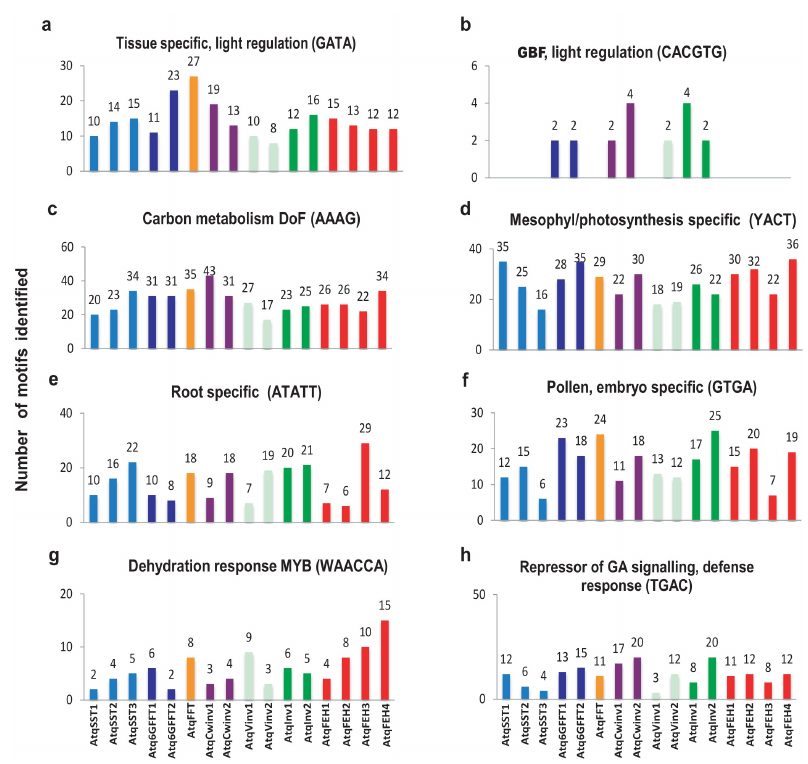
Figure 3. Abundance of transcription factor regulatory motifs identified in PGHF32 promoter regions. Conserved motifs and their associated regulatory process are indicated above each graph. PGHF32 members are indicated at the foot of each column on the x-axis and the y-axis shows the numbers of motifs identified. Each color indicates the different PGHF32 members for present in the A. tequilana genome.